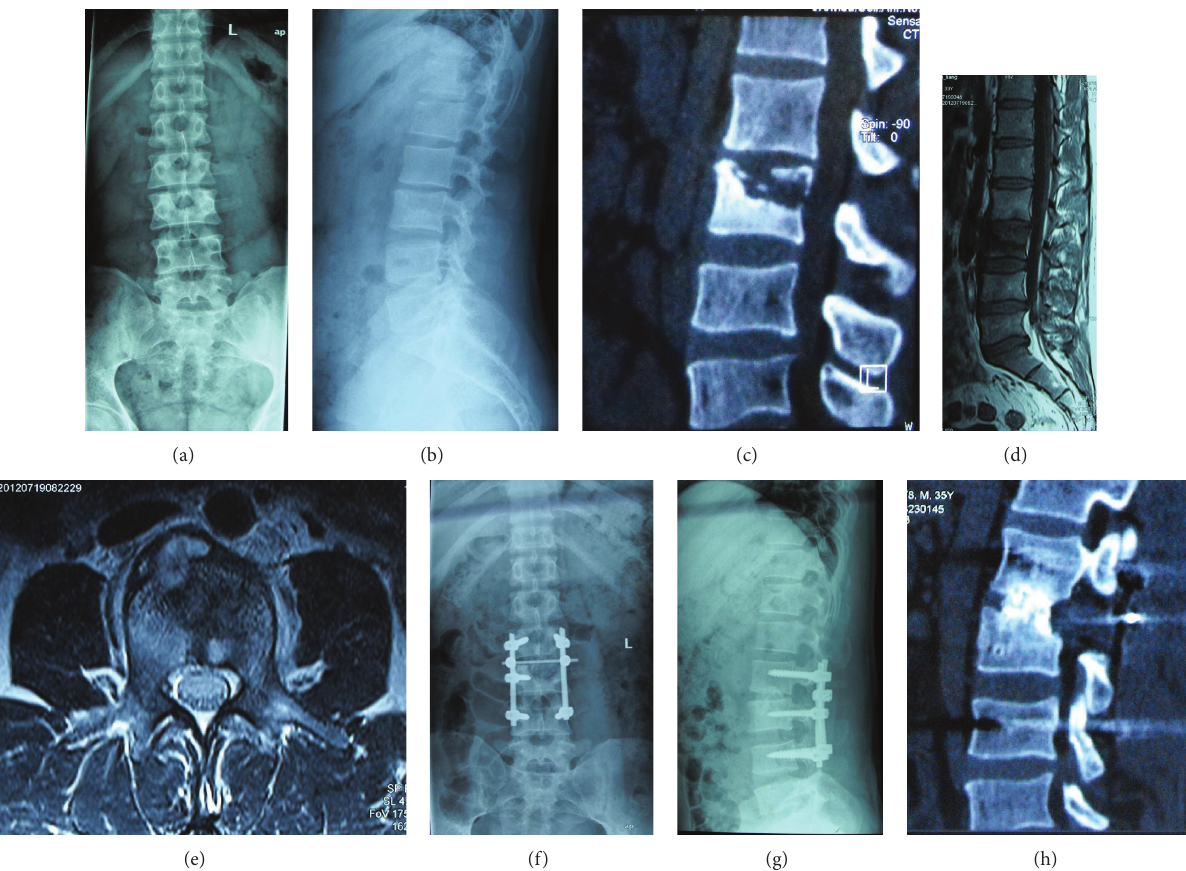
Figure 2: A 33-year-old male patient was diagnosed as having tuberculous spondylitis at L2-3 with a paravertebral abscess after a 2-month history of severe back pain (a–e). After one-stage posterior debridement, interbody fusion with autogenous bone grafting, and fixation with pedicle screw, this focal tuberculosis was removed and the spine was reconstructed in sagittal profile (f, g). 15 months postoperatively, a successful bony fusion was observed in reconstruction CT film (h).